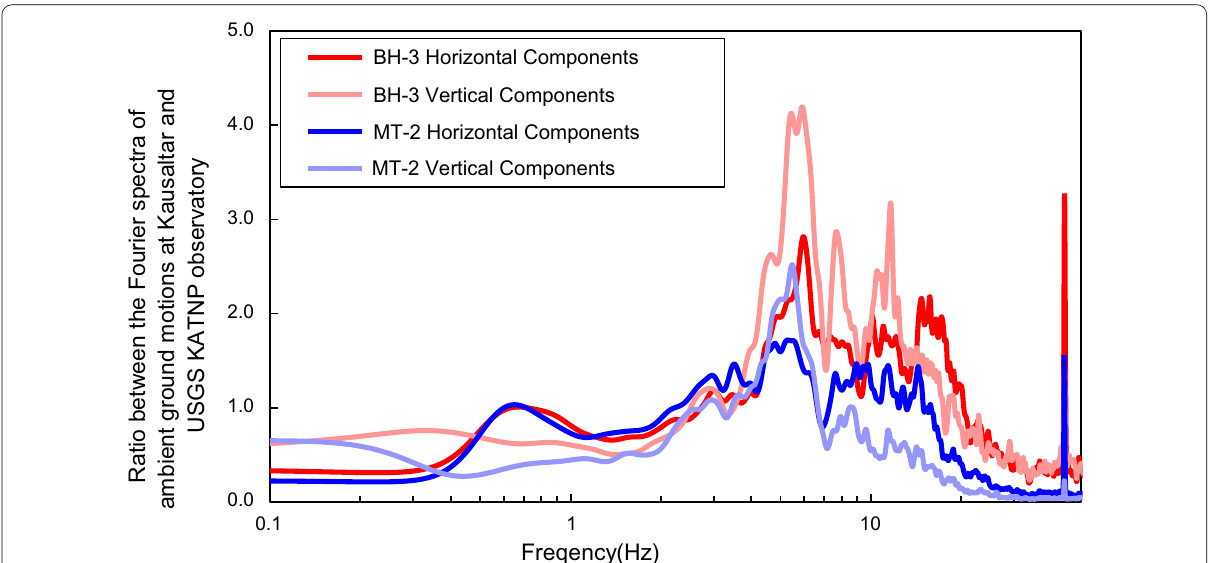
Fig. 5 Variation of frequency-domain amplitude ratio at BH-3 and MT-2 with the Fourier spectrum of the microtremor observed at USGS-3 as the reference